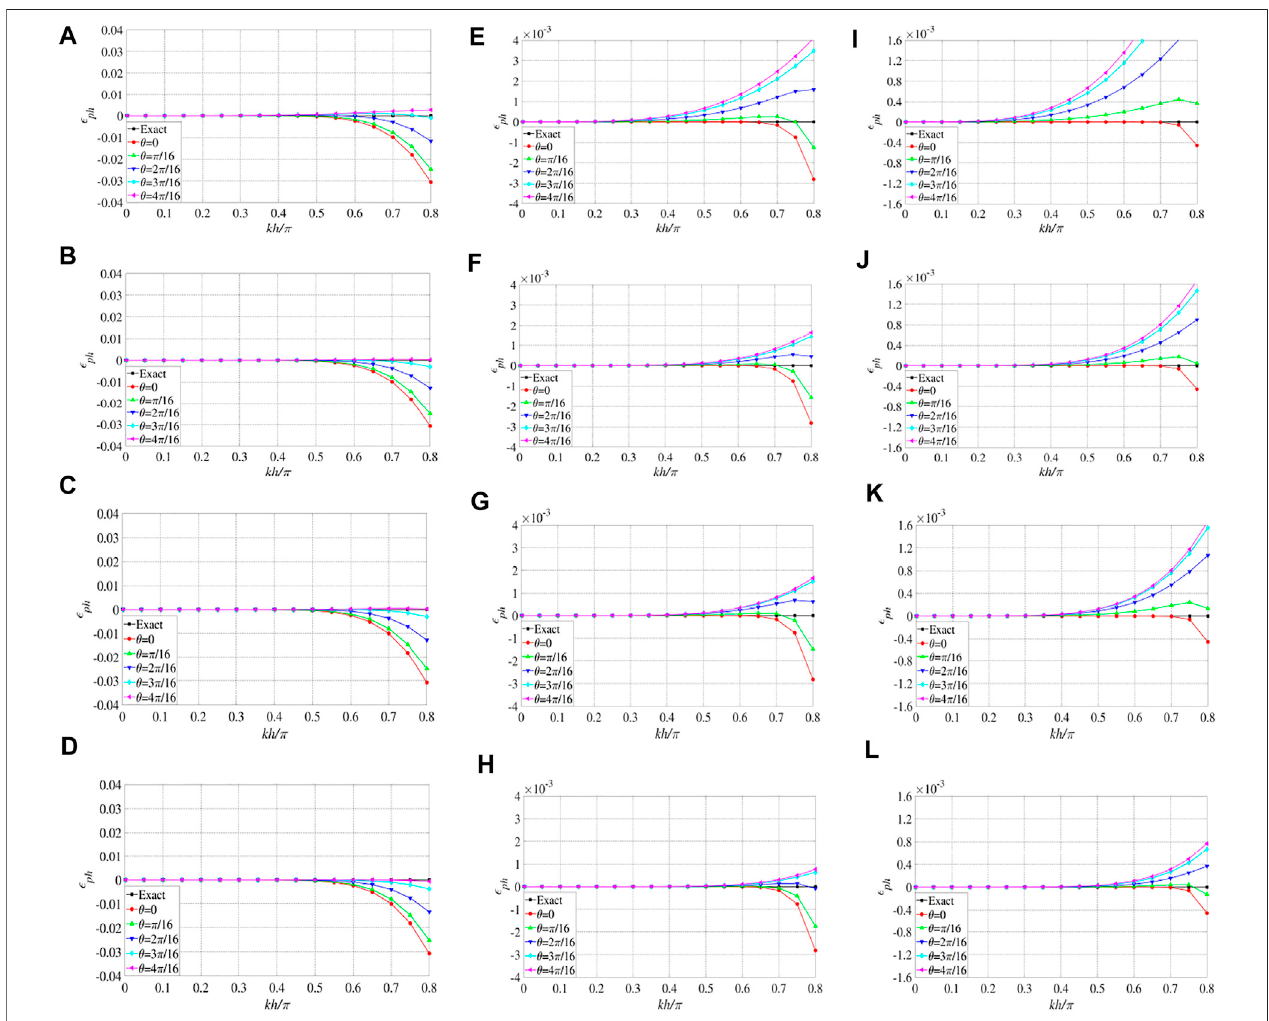
FIGURE4| Phasevelocitydispersioncurvesoftheacousticstaggered-gridFDschemeswith r (cid:2) 0 . 3. (A – D) M-SFD( M =6; N =1,2,3,and4), (E – H) M-SFD( M =18; N =1, 2, 3, and 4), (I – L) M-SFD ( M =30; N =1, 2, 3, and 4).